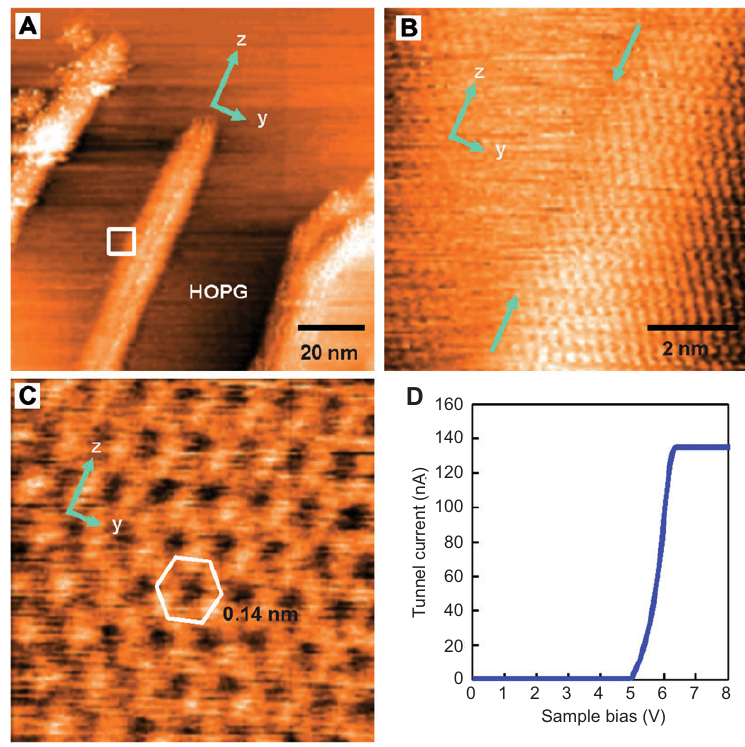
Figure 22 (A) STM image of BN nanotubes on HOPG. (B) Enlarged image of the surface of BN nanotube indicated by a square in (A). (C)